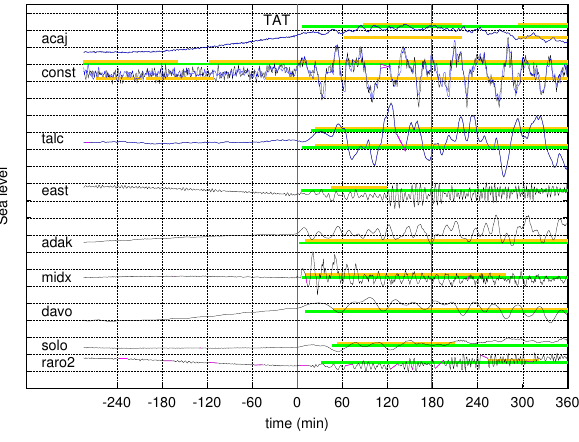
Fig. 7. Examples of tsunami records with TEDA detections. Stations are: acaj=Acajutla, El Salvador; const=Constitucion, Chile (const d1, black; const d2, blue); talc=Talcahuano, Chile; east=Easter Island, Chile; adak=Adak, Alaska; midx=Midway Is- lands, Hawaii; davo=Davao, Philippines; solo=Honiara, Solomon islands; raro2=Avatiu Rarotonga, Cook Islands. Notice that Aca- jutla and Talchuano have two records by different sensors (Table 1) and that they do overlap perfectly in this graph. Horizontal lines mark the tsunami state from the tsunami detection method (green), and the alert interval from the secure detection analysis (orange). For the three stations with two records, there are two pairs of hor- izontal lines: the upper pair for channel 1 and the lower pair for channel 2. Vertical red lines mark the beginning and end of the 3h- long TDI. On the vertical axis, ticks are at 1m distance.